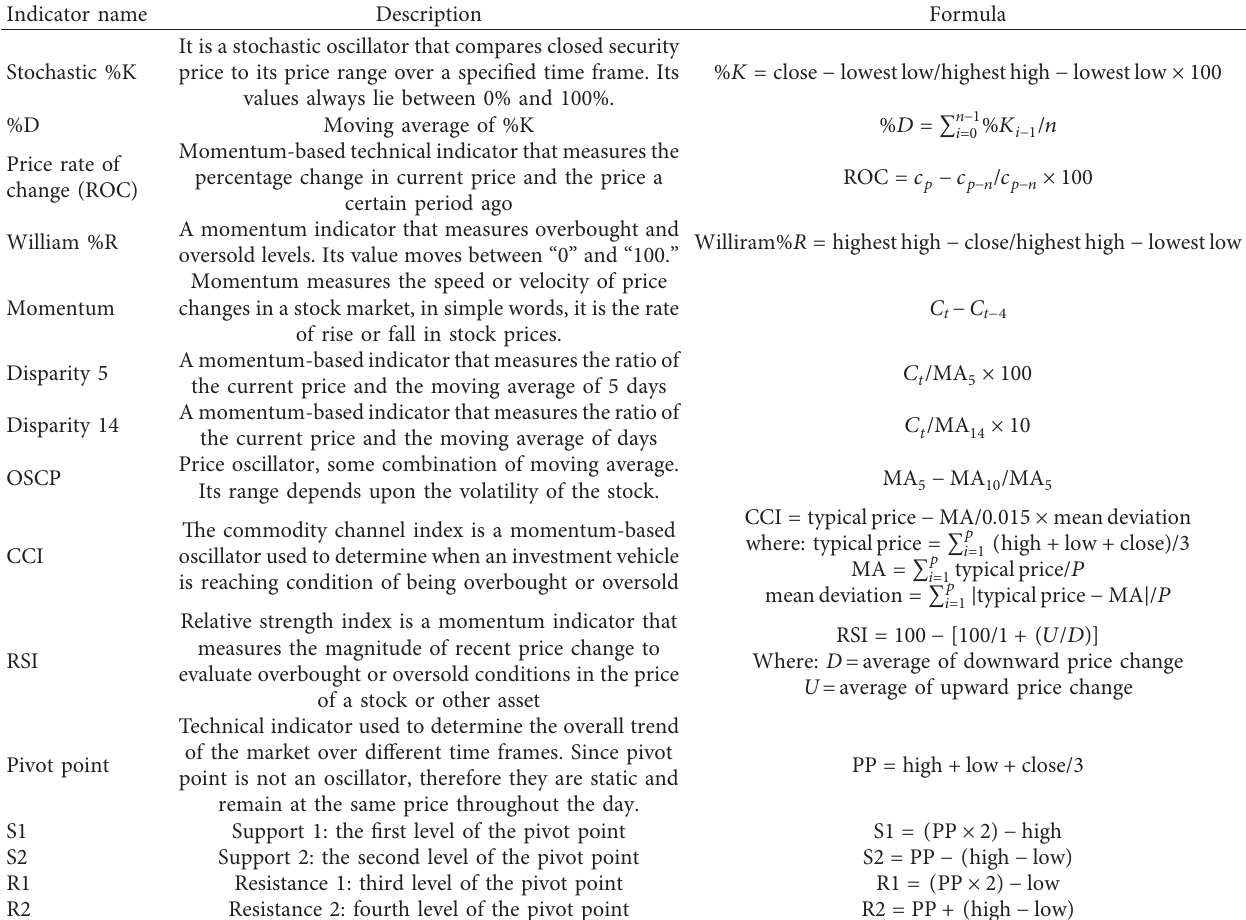
Table 1: The selected technical indicators and their mathematical expressions.